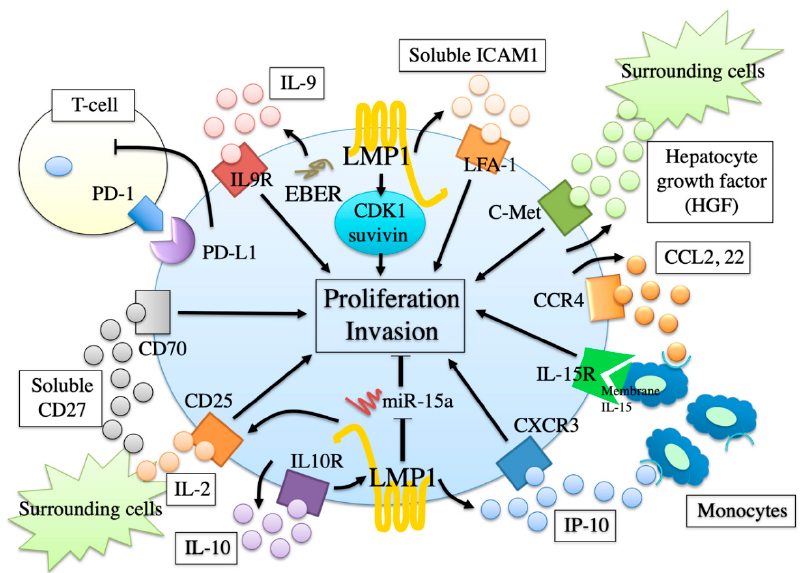
Figure 3. The biological characteristics of extranodal NK/T-cell lymphoma, nasal type cells. A wide variety of intracellu- lar/cell surface molecules, cytokines, chemokines, and micro RNAs were involved in the lymphomagenesis of ENKTL- NT.